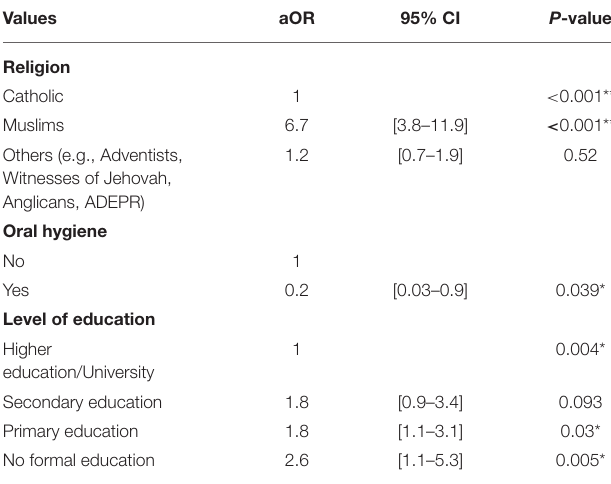
TABLE 4 | Multivariate analysis for factors associated with oral cancer treatment. Values